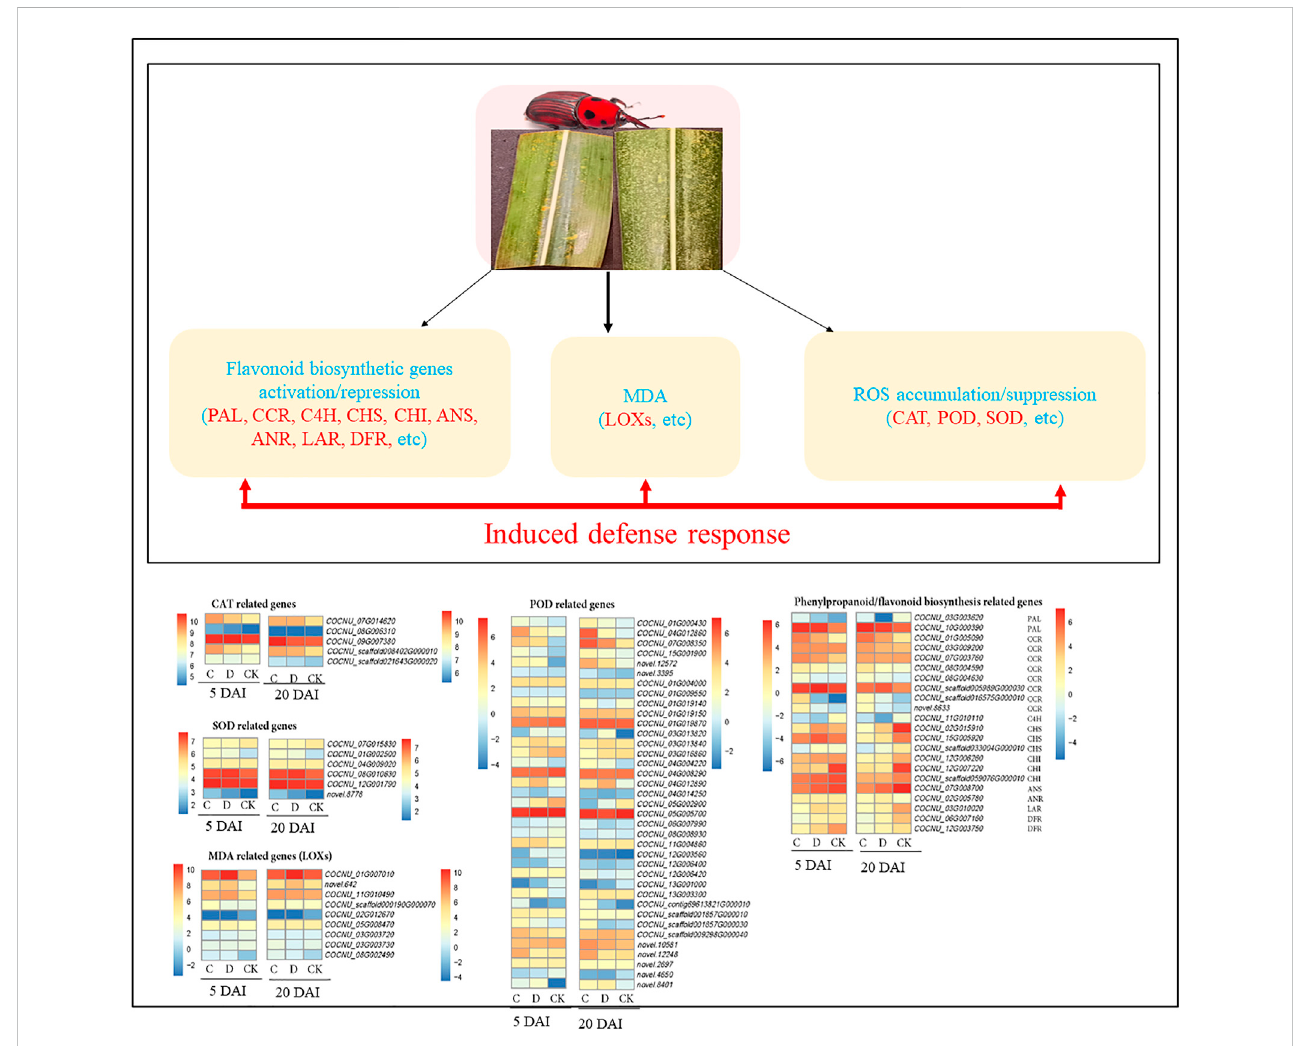
FIGURE 4 Reactiveoxygenspecies(ROS)scavengingrelatedgeneexpressionchangesinthetwopopulationdensitiesofredpalmweevil(RPW)ascomparedtoCK (CK = no RPW; C = 15 males and 21 females; D = 20 males and 28 females) at 5 and 20 DAI in coconut leaves. The genes highlighted in red text were differentially expressed, POD: peroxidases; SOD: superoxide dismutase; CAT: catalase, MDA: monodehydroascorbate, and LOXs: lipoxygenase. Heatmap of log2 transformation offragments per kilobaseof exon permillion fragments mapped (FPKM) values ofROS and phenylpropanoid/ fl avonoid biosynthesis genes with pheatmap package in R (Kolde and Kolde, 2018). PAL: phenylalanine ammonia-lyase [EC:4.3.1.24]; CCR: cinnamoyl-CoA reductase [EC:1.2.1.44]; C4H: trans-cinnamate 4-monooxygenase [EC:1.14.14.91]; CHS: chalcone synthase [EC:2.3.1.74]; CHI: chalcone isomerase [EC:5.5.1.6]; ANS: anthocyanidin synthase [EC:1.14.20.4]; ANR: anthocyanidin reductase [EC:1.3.1.77]; LAR: leucoanthocyanidin reductase [EC:1.17.1.3] and DFR: bifunctional dihydro fl